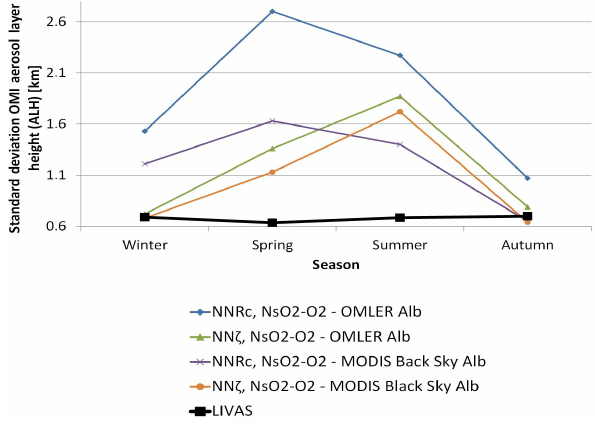
Figure 16. Standard deviation of the OMI ALH retrievals obtained for the cloud-free scenes with MODIS τ( 550nm ) ≥ 1 . 0 over north- east Asia. The retrievals are done for cloud-free scene over 3 years, 2005–2007. Aerosol single scattering albedo ω 0 = 0.95 is assumed. OMLER and MODIS black-sky surface albedo, and the NN config- and NN τ,N s with MODIS τ (550nm) urations (NN R c ,N s O2 − O2 O2 − O2 as input) are alternatively considered (see Sect.